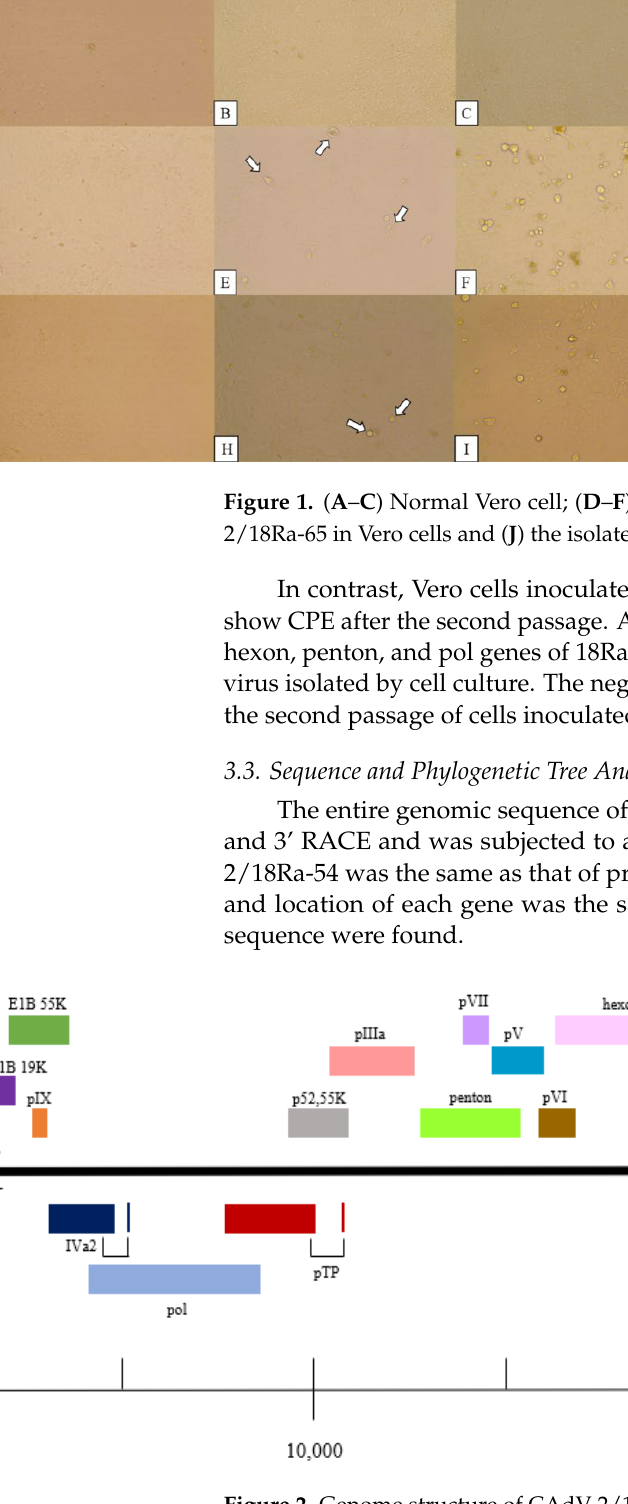
Figure 2. Genome structure of